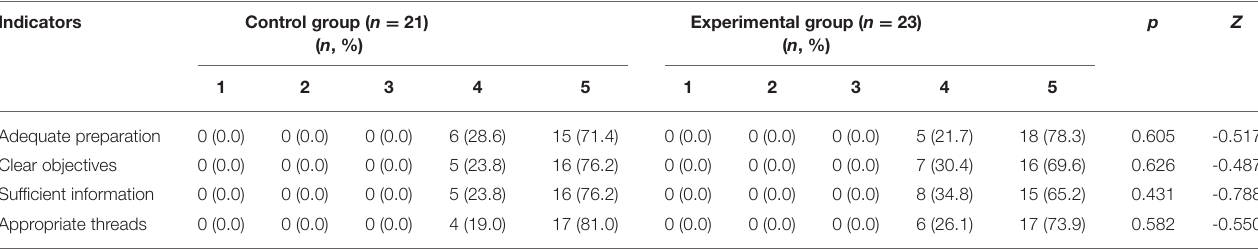
TABLE 4A | Evaluation of the teacher’s performance (simulation